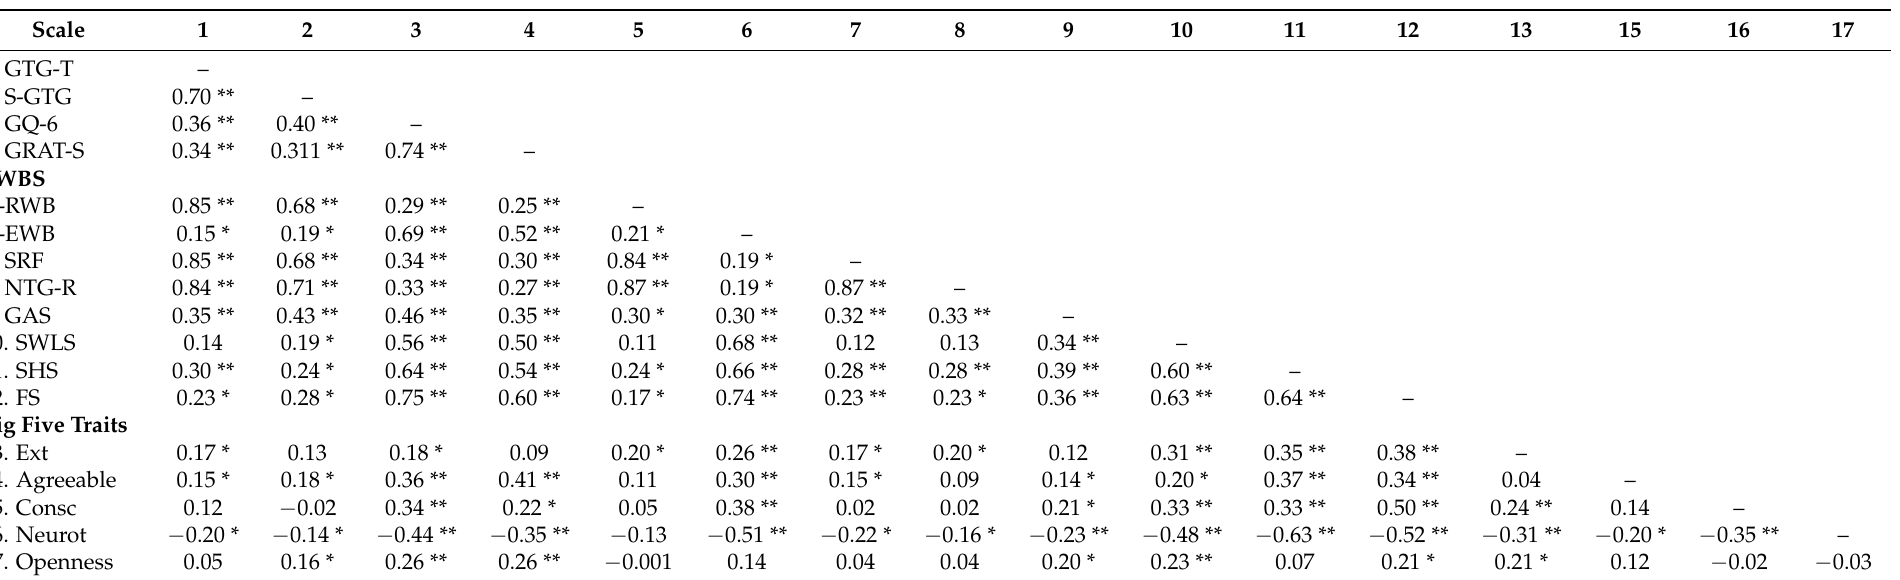
Table 1. Correlations of Time 1